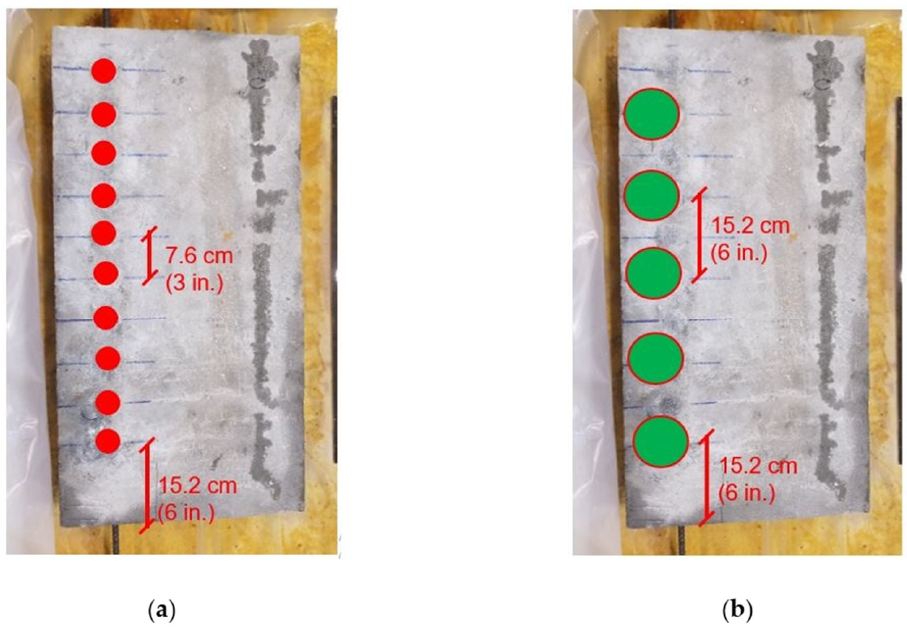
Figure 3. Test locations on the specimens: ( a ) UGWL; ( b ) HCP.